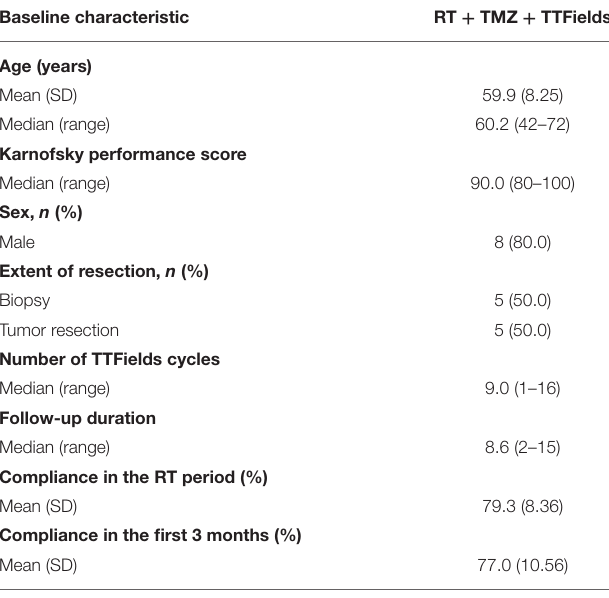
TABLE 1 | Patient baseline characteristics and treatments. TABLE 2 | RT treatment